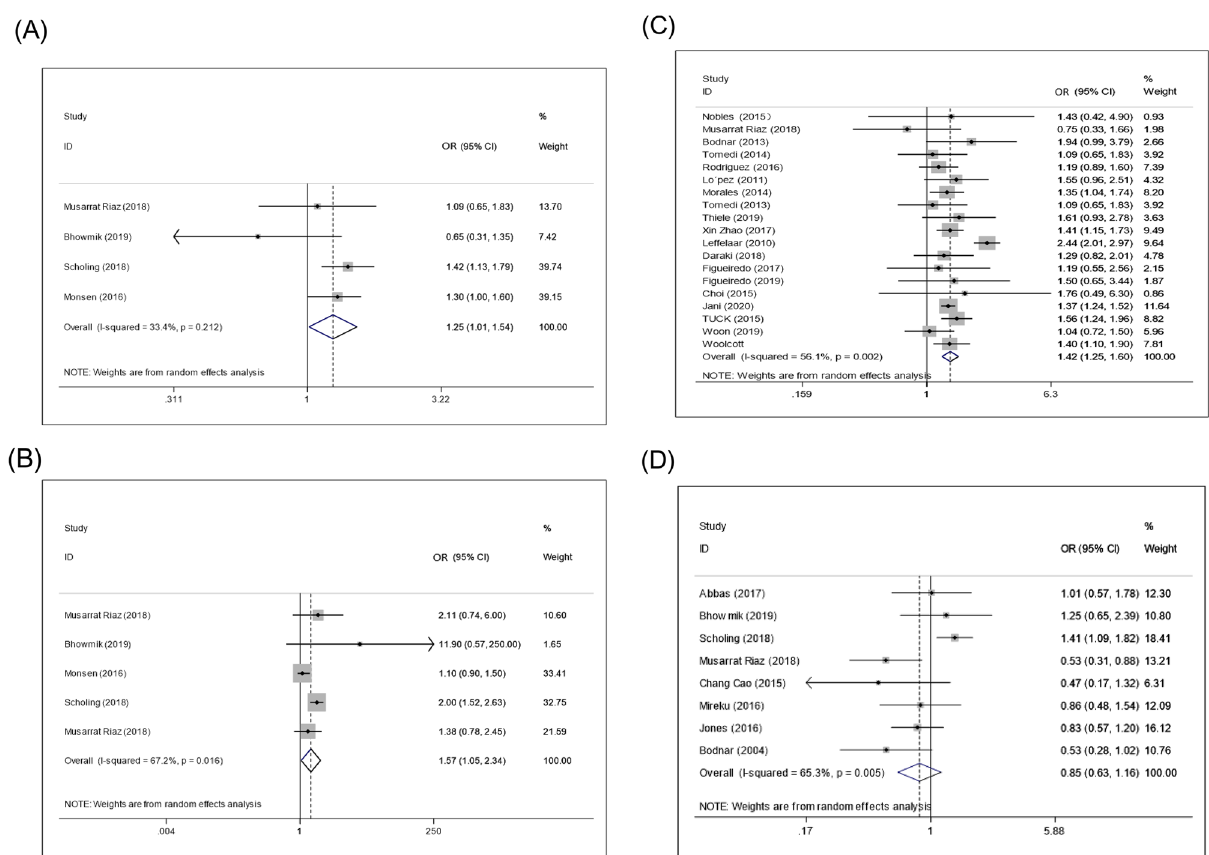
Figure 3. Forest plots of the relationship between prepregnancy overweight and micronutrient deficiency, including that of vitamin B12 ( A ), folate ( B ), vitamin D ( C ), and iron ( D